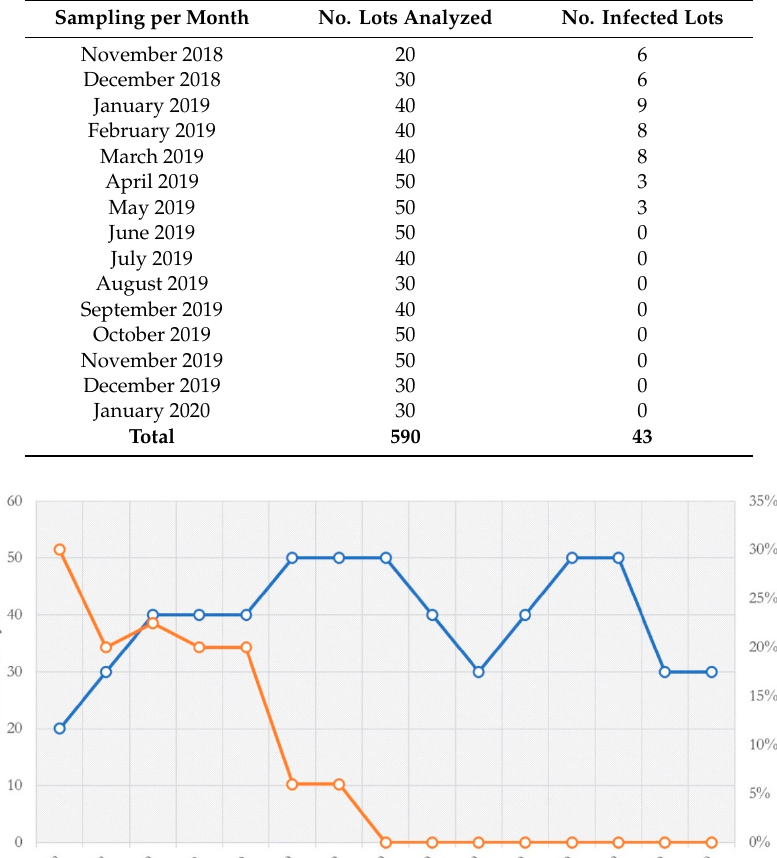
Table 1. Number of analyzed seed lots per month and number of detected infected seed lots. Sampling per Month No. Lots Analyzed No. Infected Lots